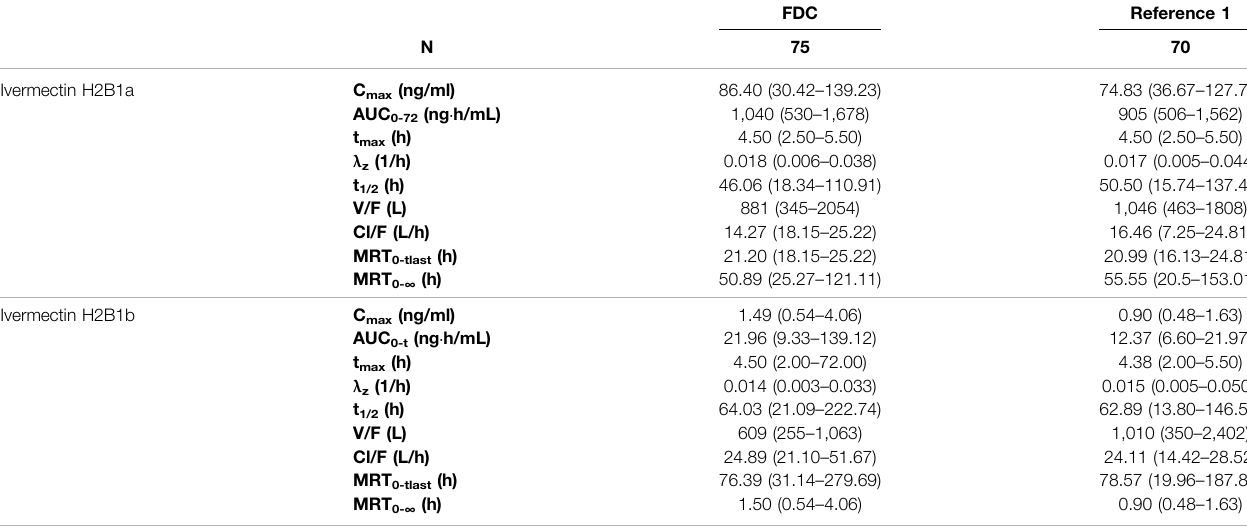
TABLE 1 | Descriptive statistics of the main pharmacokinetic parameters of ivermectin H2B1a and ivermectin H2B1b following the administration of ivermectin/albendazole fi xed-dose combination (FDC) or ivermectin (REFERENCE 1).